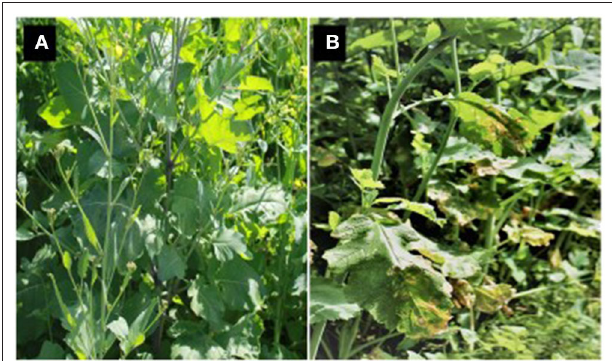
FIGURE 8 | Brassica carinata genotype ATC94129P showing complete resistance (A) and highly susceptible (B) B. juncea under equal disease pressure after inoculation of a mixture of Neopseudocercosporella capsellae isolates.